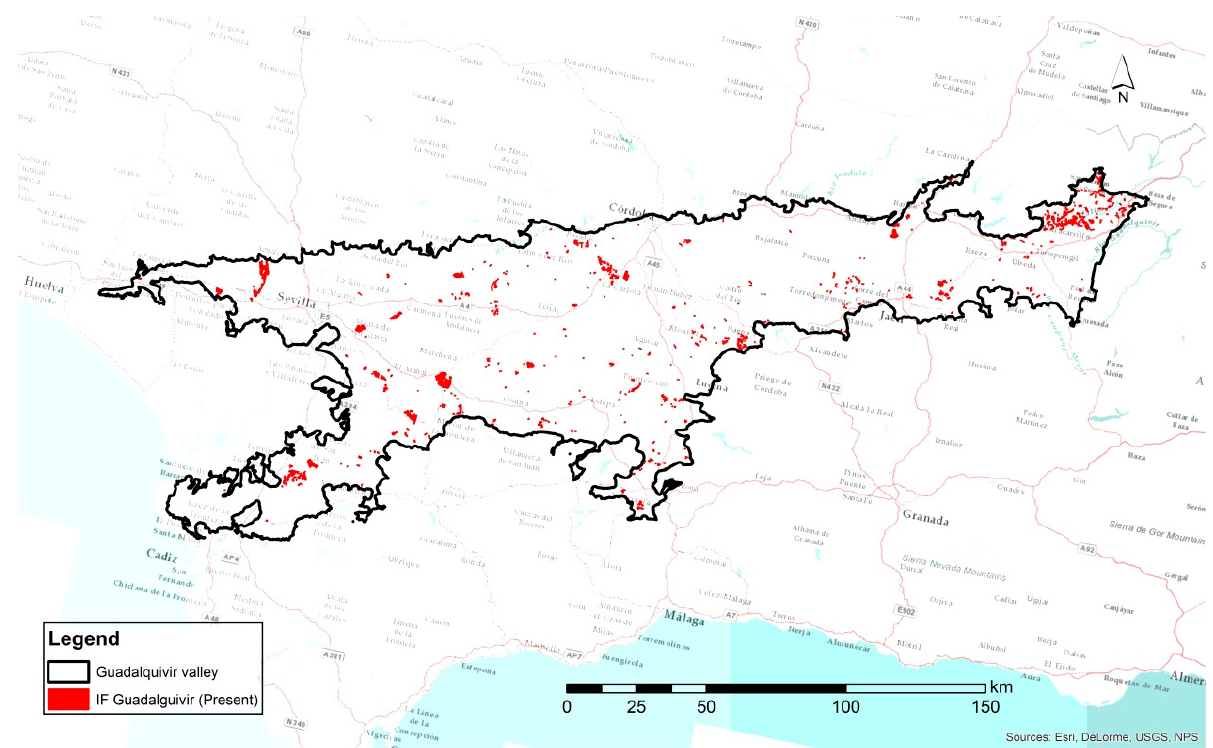
Figure 5. Present distribution of IFs in the Guadalquivir valley. Table 2. Area, number of polygons, total area of Island Forests (IFs), mean area, perimeter and mean perimeter of the study regions.